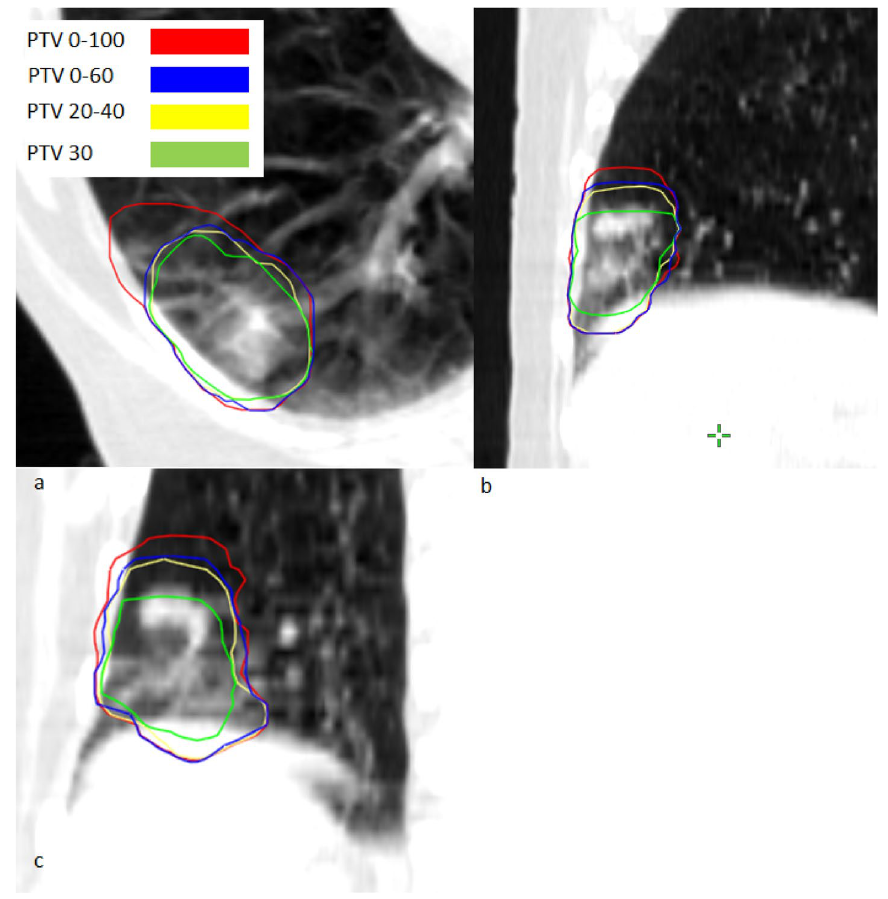
Figure 2. PTV contours for different gating window sizes for patient case 4 in CTs in transversal ( a ), sagittal ( b ) and coronal ( c )